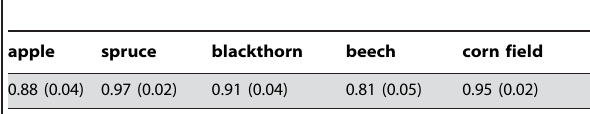
Table 1. Area under the ROC curve for the five classification tasks of one species vs. the other